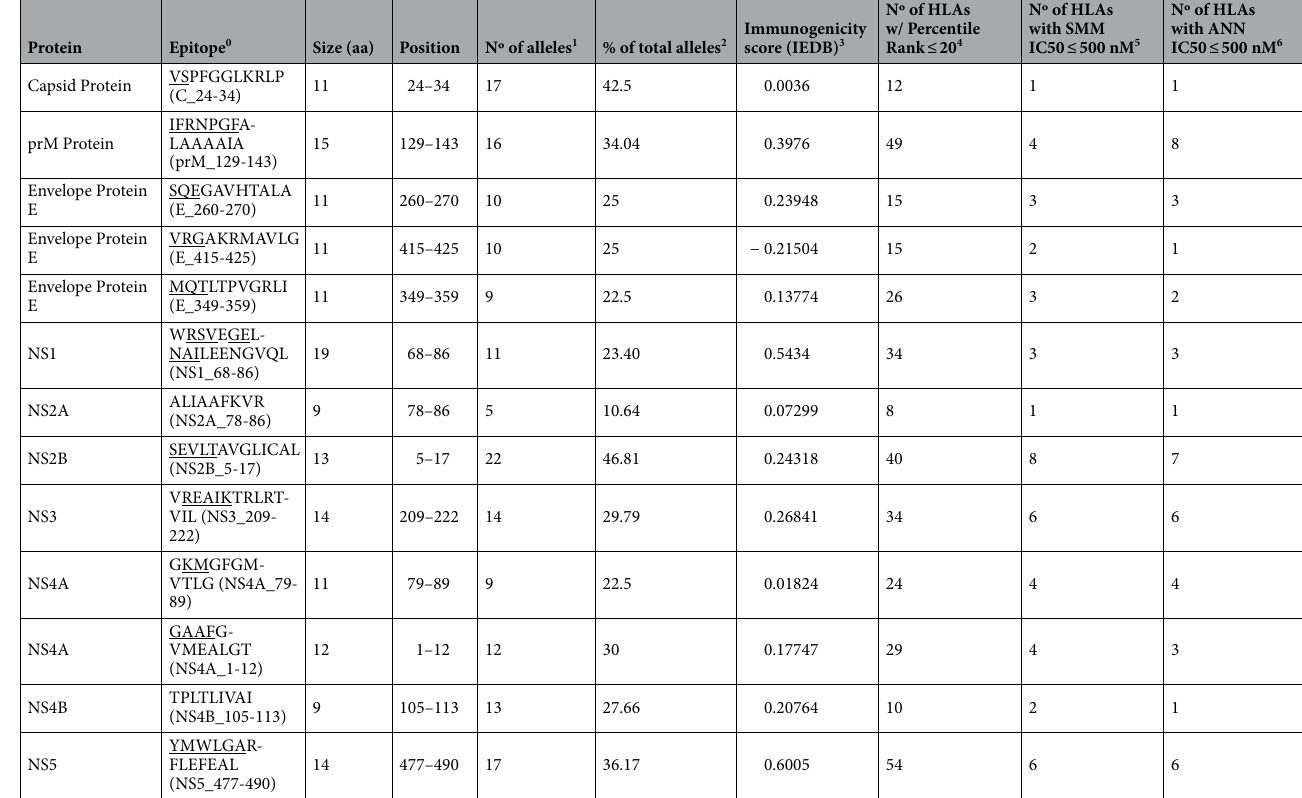
Table 1. Zika virus CD8 peptide selection based on multiparameters using immunoinformatics tools. 0—Underlined are the first aminoacids of a 9-mer peptide predicted as having percentile rank ≤ 20 as calculated by IEDB (http:// tools. iedb. org/ mhci/). 1—Total number of HLA-I covered by the peptide as predicted by Propred1. All 47 alleles were selected, and the percentage of the highest scoring peptides,